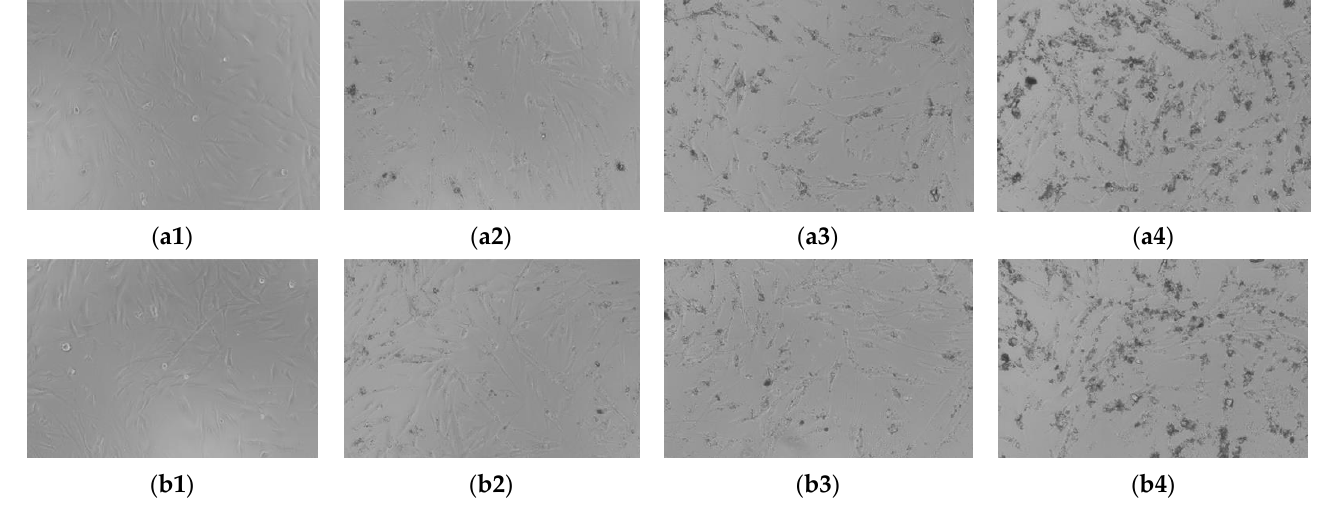
Figure 10. Appearance of primary human gingival fibroblasts (HGF) in culture for 24 h: ( a ) Group 5 (GC) and ( b ) Group 6 (BC), for ( 1 ) control, ( 2 ) 50 μg /mL, ( 3 ) 100 μg /mL, and ( 4 ) 250 μg /mL. The (GC) and ( b ) Group 6 (BC), for ( 1 ) control, ( 2 ) 50 µ g/mL, ( 3 ) 100 µ g/mL, and ( 4 ) 250 µ g/mL. The photos were obtained using the 20× lens. photos were obtained using the 20 ×